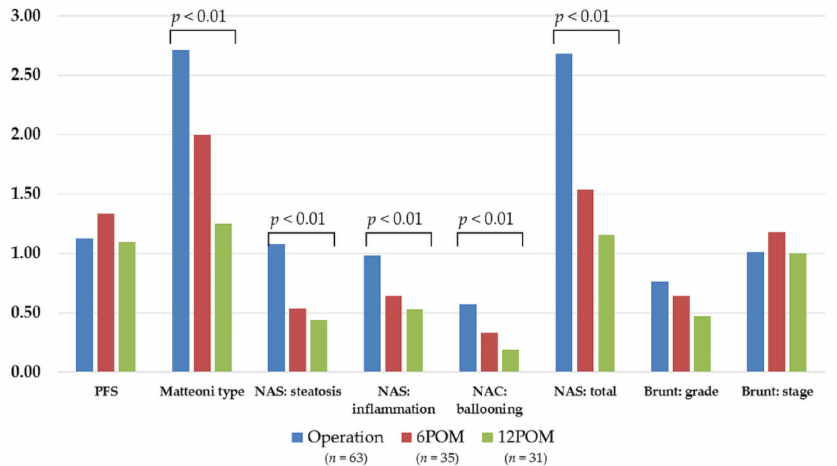
Figure 8. Changes in histopathological scoring and classifications of NASH evaluated by protocol liver biopsy. Abbreviations: PFS, Pericellular fibrosis score; NAS, NAFLD activity score; 6POM, 6 months after LSG; 12POM, 12 months after